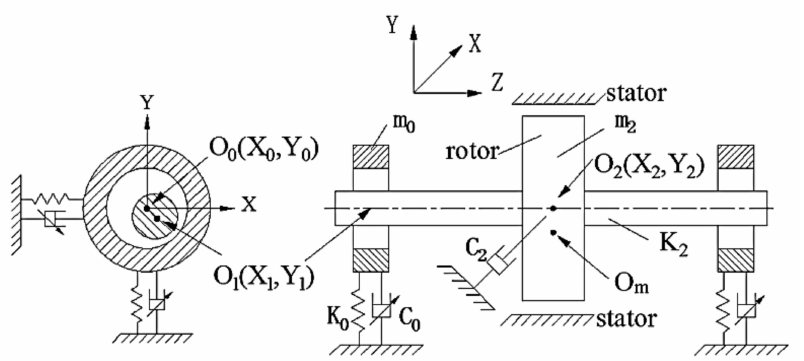
Figure 17. Nonlinear damping suspension in a flexible rotor in journal bearings